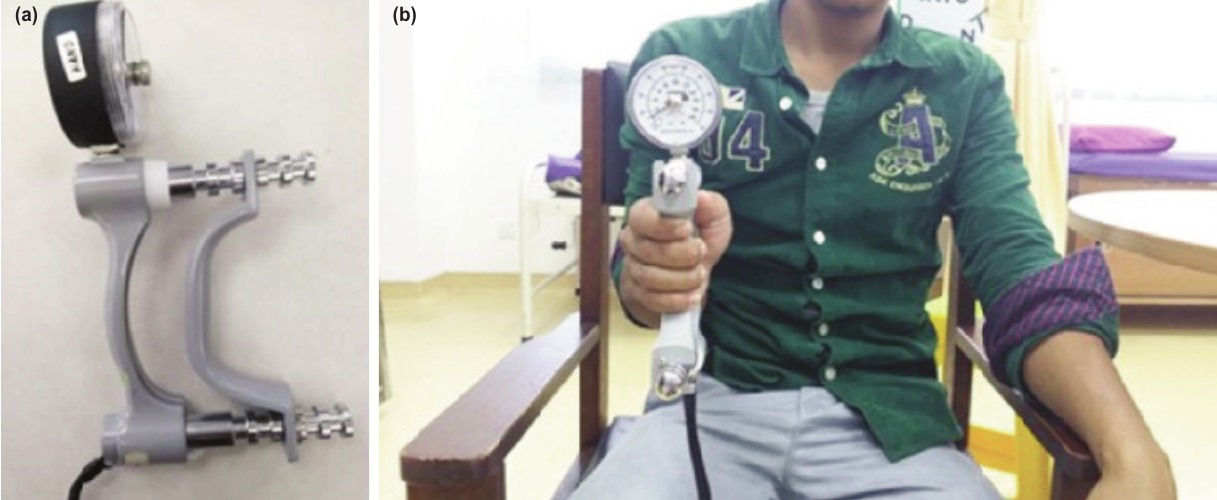
(a) A photo showing a JAMAR hydraulic hand-held Dynamometer used in our study, (b) a photo demonstrating on how the Fig. 2: measurement of grip strength was performed by using that device.